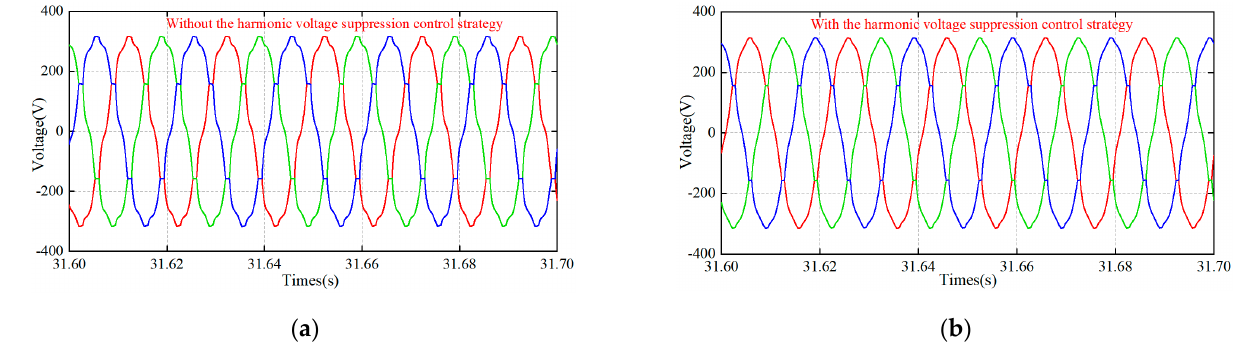
Figure 13. Experimental results for the voltage waveform of microgrid for PCC point ( a ) without the harmonic voltage suppression of multi-inverter parallel VSG adding a secondary control strategy; ( b ) with the harmonic voltage suppression of multi-inverter parallel VSG adding a secondary control strategy.